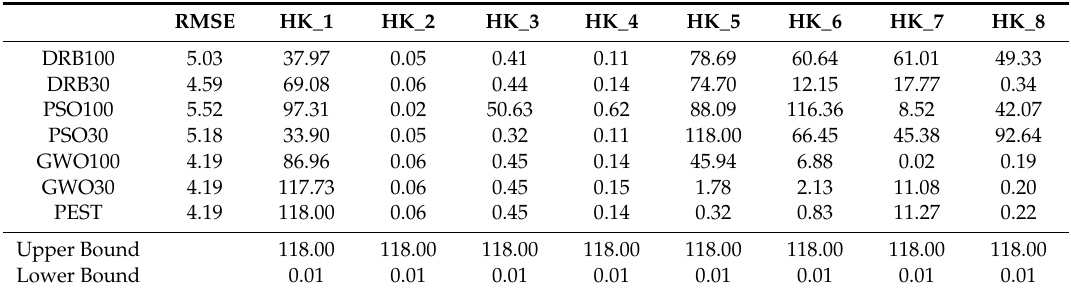
Table 3. RMSE and horizontal conductivity (HK_#) values for the best run of each optimizer/agent number pair. Similar values per HK zone are colored the same.